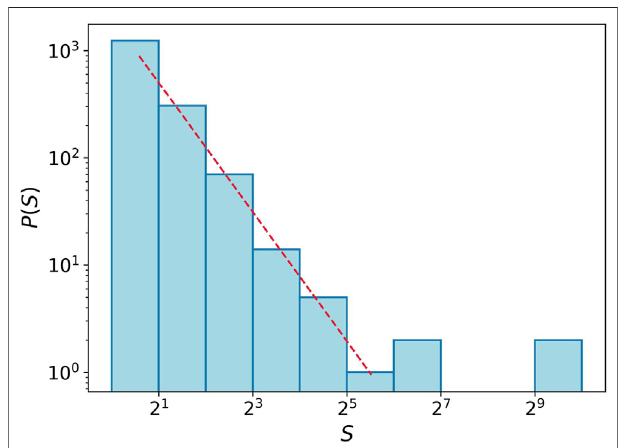
FIGURE8| Pair distribution function against the distance betweencells. The pair distribution function is plotted for three values of the attraction strength Δ = 1.2, Δ = 1.5, and Δ = 2. For all the three values, the attraction range is equal to 1.5. The power-law behavior is seen for Δ = 1.5.